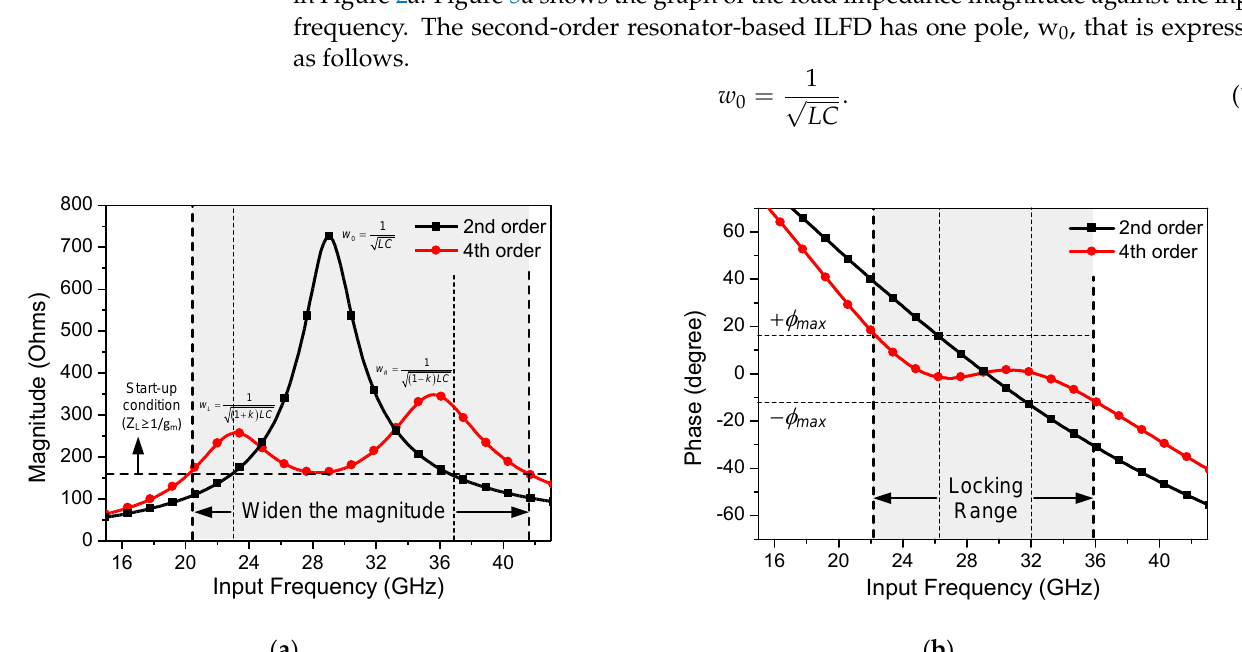
Figure 5. ( a ) Simulated magnitude plot and ( b ) phase plot of second-order resonator-based ILFD and fourth-order resonator-based ILFD.